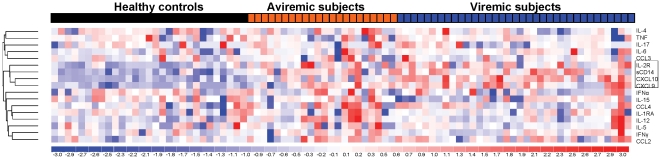
Plasma CXCL9, CXCL10, sIL-2R, and sCD14 represent a biomarker cluster that distinguishes HIV subjects from healthy uninfected controls.(A) Hierarchical clustering (supervised only by sample) by Euclidean distance and average linkage of 17 plasma biomarkers in 57 HIV patients and 29 healthy uninfected controls shows increased plasma levels and clustering of CXCL9, CXCL10, sIL-2R, and sCD14 (highlighted in box) in HIV subjects compared to healthy controls. In heat maps, red and blue represent increased and decreased levels relative to the mean level of a biomarker, respectively. Each column and row defines individual patient and biomarkers, respectively.